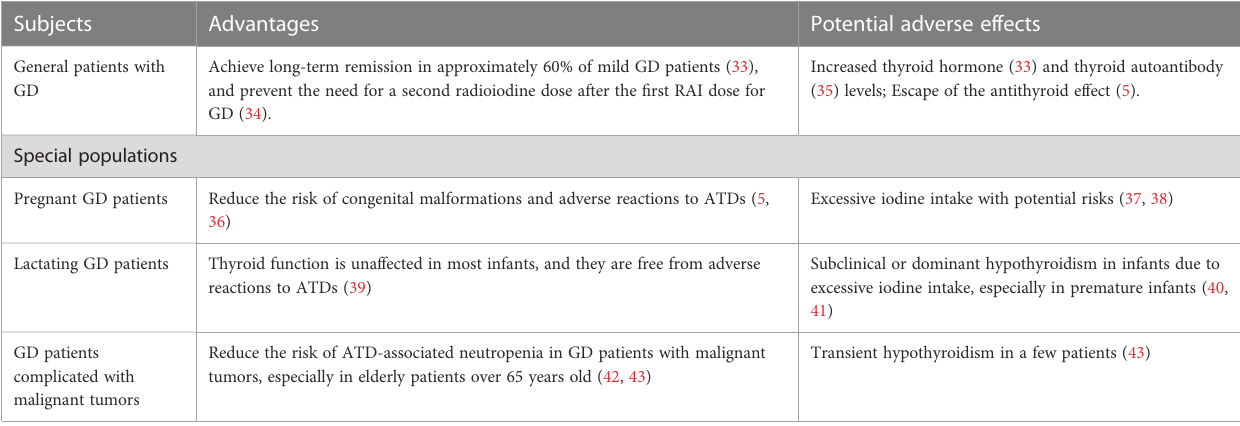
TABLE 1 The administration of potassium iodine in different patients.